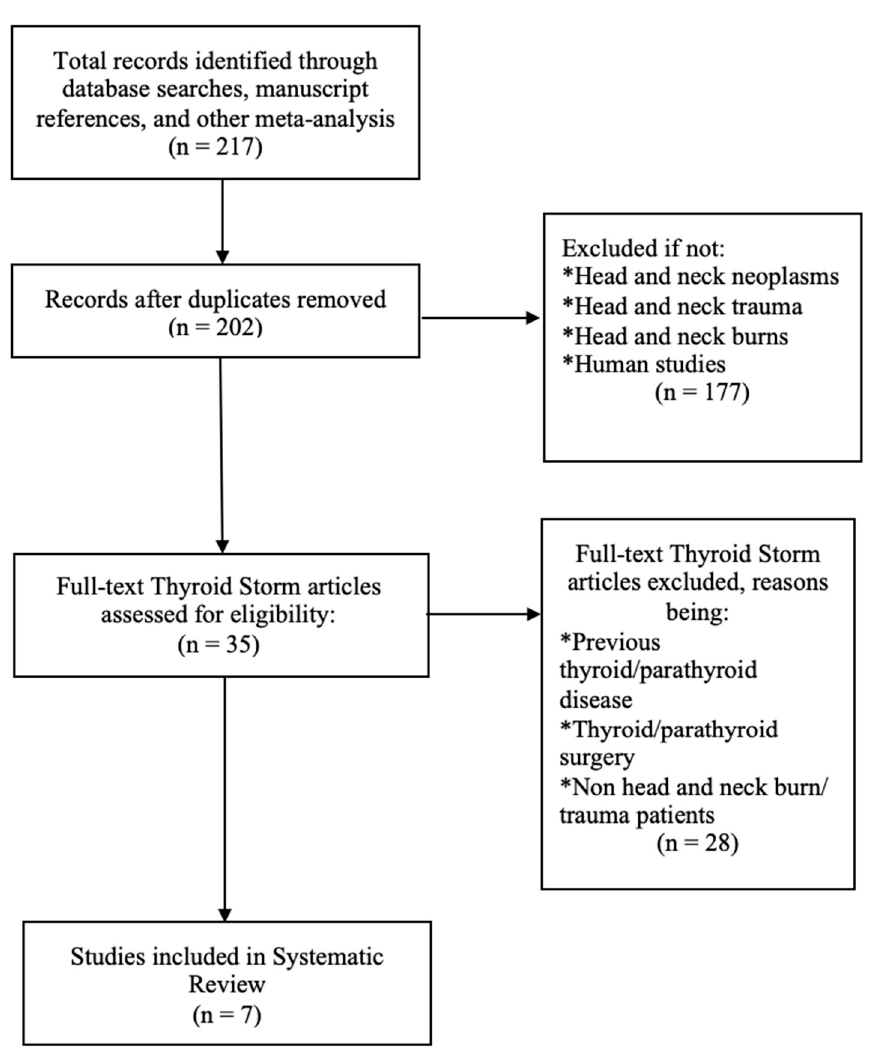
Figure 1. PRISMA flow diagram.